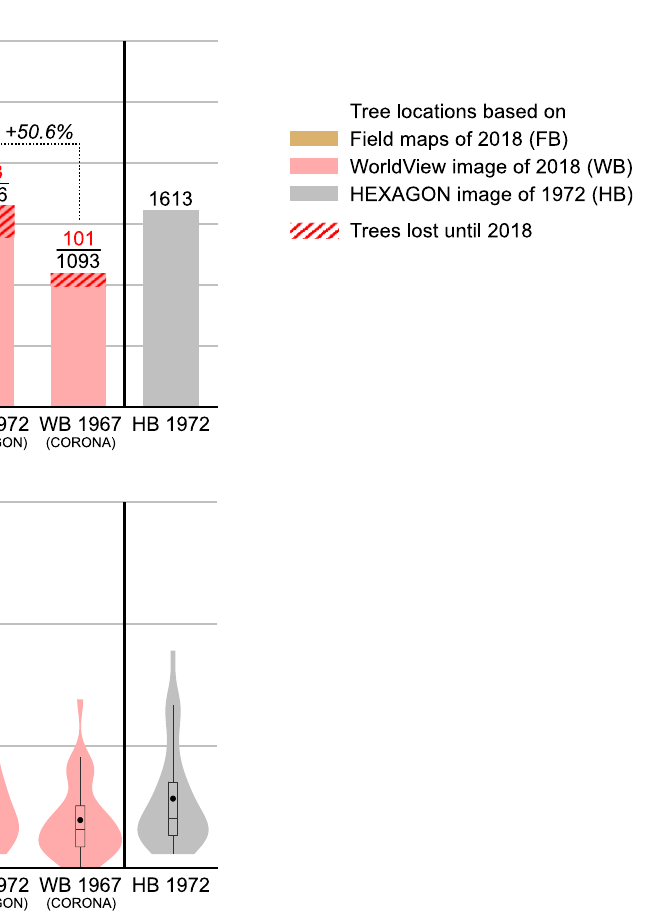
Frontiers in Environmental Science |